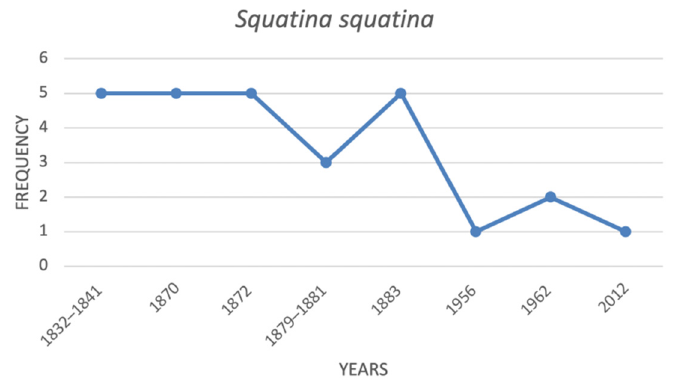
Figure 5. Temporal trend of Squatina squatina.